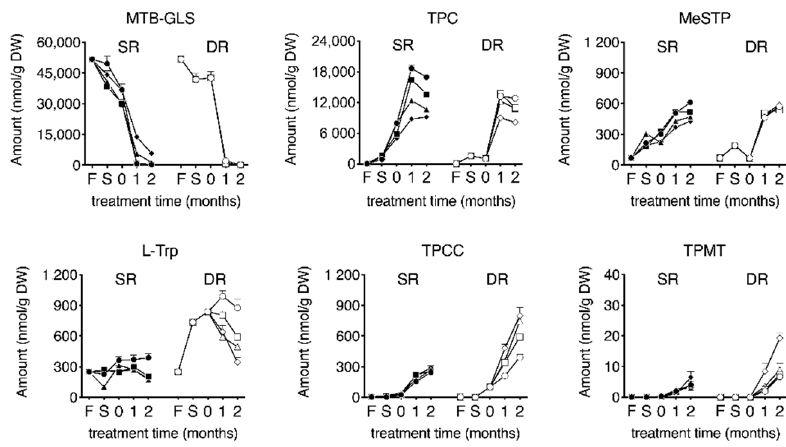
Figure 5. Change in the amount of each yellow pigment and related substances during the dehydrating and salting process. SR indicates dehydration by salting (shio-oshi takuan-zuke); DR indicates dehydration by sun-drying (hoshi takuan-zuke); F indicates the amount of each pigment obtained from fresh daikon; S indicates the amount of each pigment obtained from the dehydrated daikon after one week of salting. “0” time point indicates the start of salt-aging. Symbols refer to di ff erent concentrations of McIlvaine bu ff ering agent (mmol / kg): • , SR0; (cid:4) , SR10; (cid:78) , SR20; (cid:117) , SR40; , DR0; (cid:3) , DR10; (cid:52) , DR20; (cid:35) , DR40. Values are mean ± standard deviation (SD) ( n = 4). Data are analyzed (cid:51) using two-way Analysis of variance (ANOVA), followed by Tukey’s multiple comparison